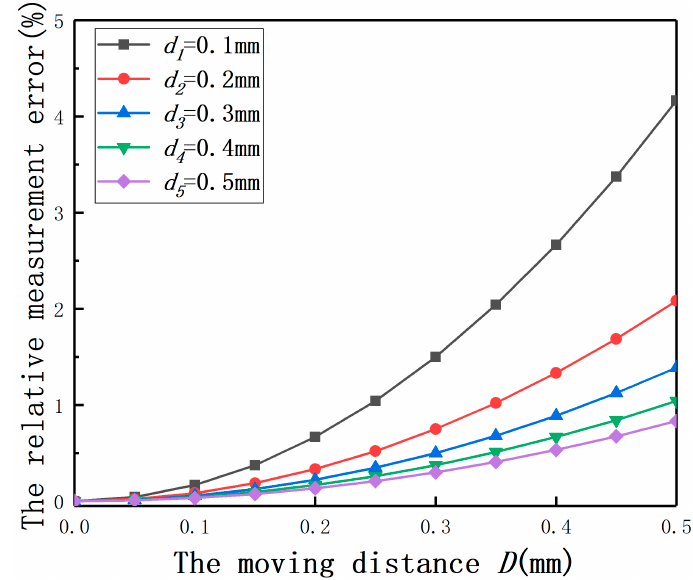
Figure 35. The relative measurement errors with the moving distance of the sensor 2.